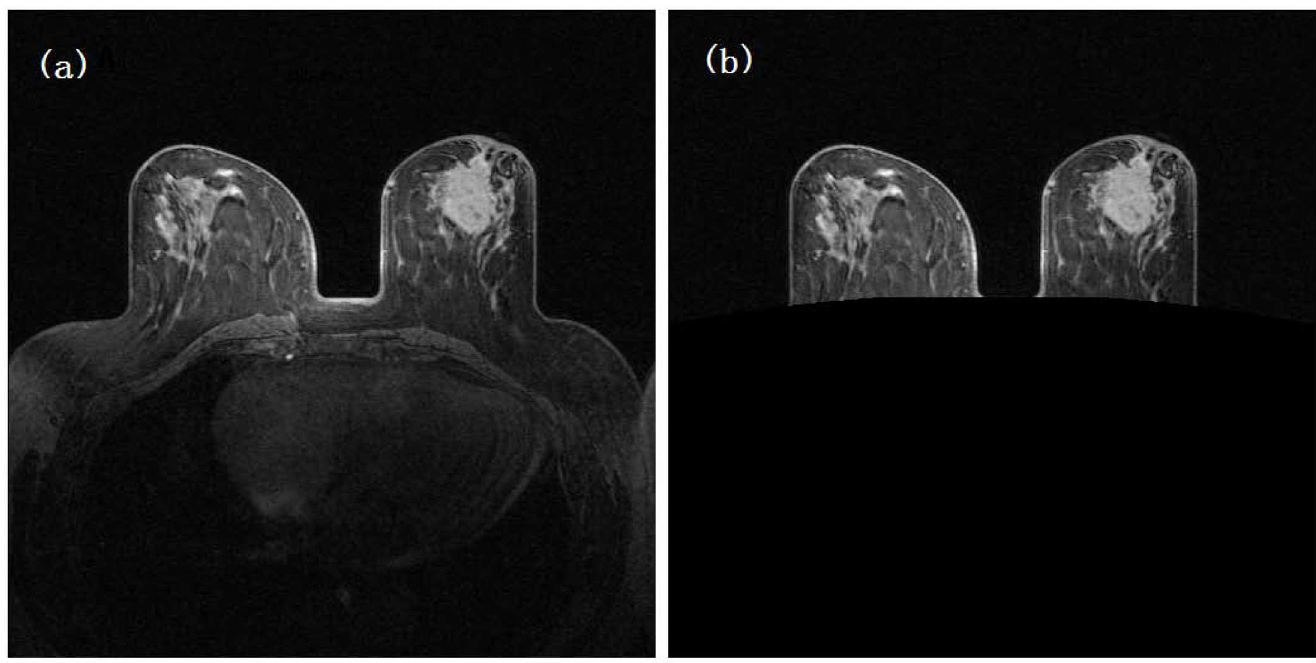
Fig 1. An example of a breast DCE-MRI slice. (a) and its CAD-segmented breast regions depictedon the image slice before contrast agent injection(S- 0) in which the non-breast regions behindthe chest wall are